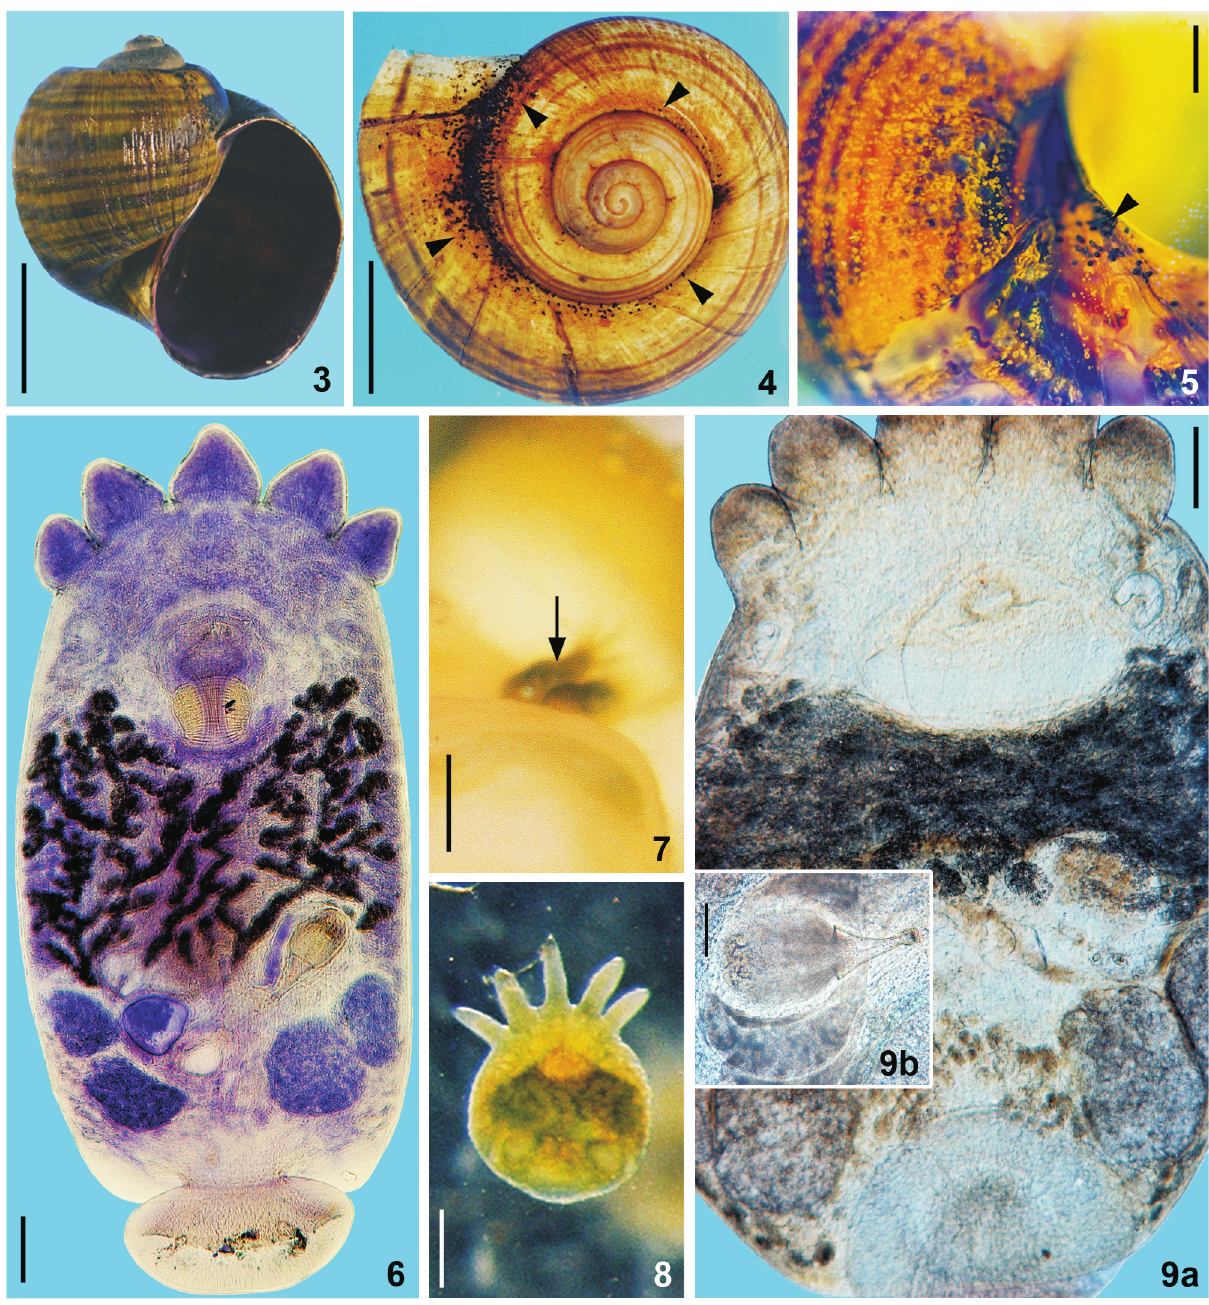
Figures 3-9. Pomacea canaliculata and Temnocephala iheringi . (3-5) Pomacea canaliculata : (3) ventral view, bar = 2 cm; (4) apical view, showing the increase in numbers of temnocephalan eggs, as the host grows documenting the growth of the infrapopulation (head arrows), bar = 1 cm; (5) umbilicus showing eggs (head arrow), bar = 0.5 cm. (6-9) Temnocephala iheringi : (6) adult specimen, stained in Delafield’s hematoxylin, bar = 100 µm; (7) two live specimens (arrow) in the pallial cavity of a snail recently euthanized, bar = 4 mm; (8) live, adult specimen showing the greenish body pigment, bar = 1 mm; (9a) live, adult specimen under the light microscope showing lack of the red pigment of the eyes, bar = 250 µm; (9b) Inset, showing the terminal male genitalia with the straight cirrus in higher magnification, typical of T. iheringi , bar = 100 ZOOLOGIA 27 (2): 245–257, April, 2010